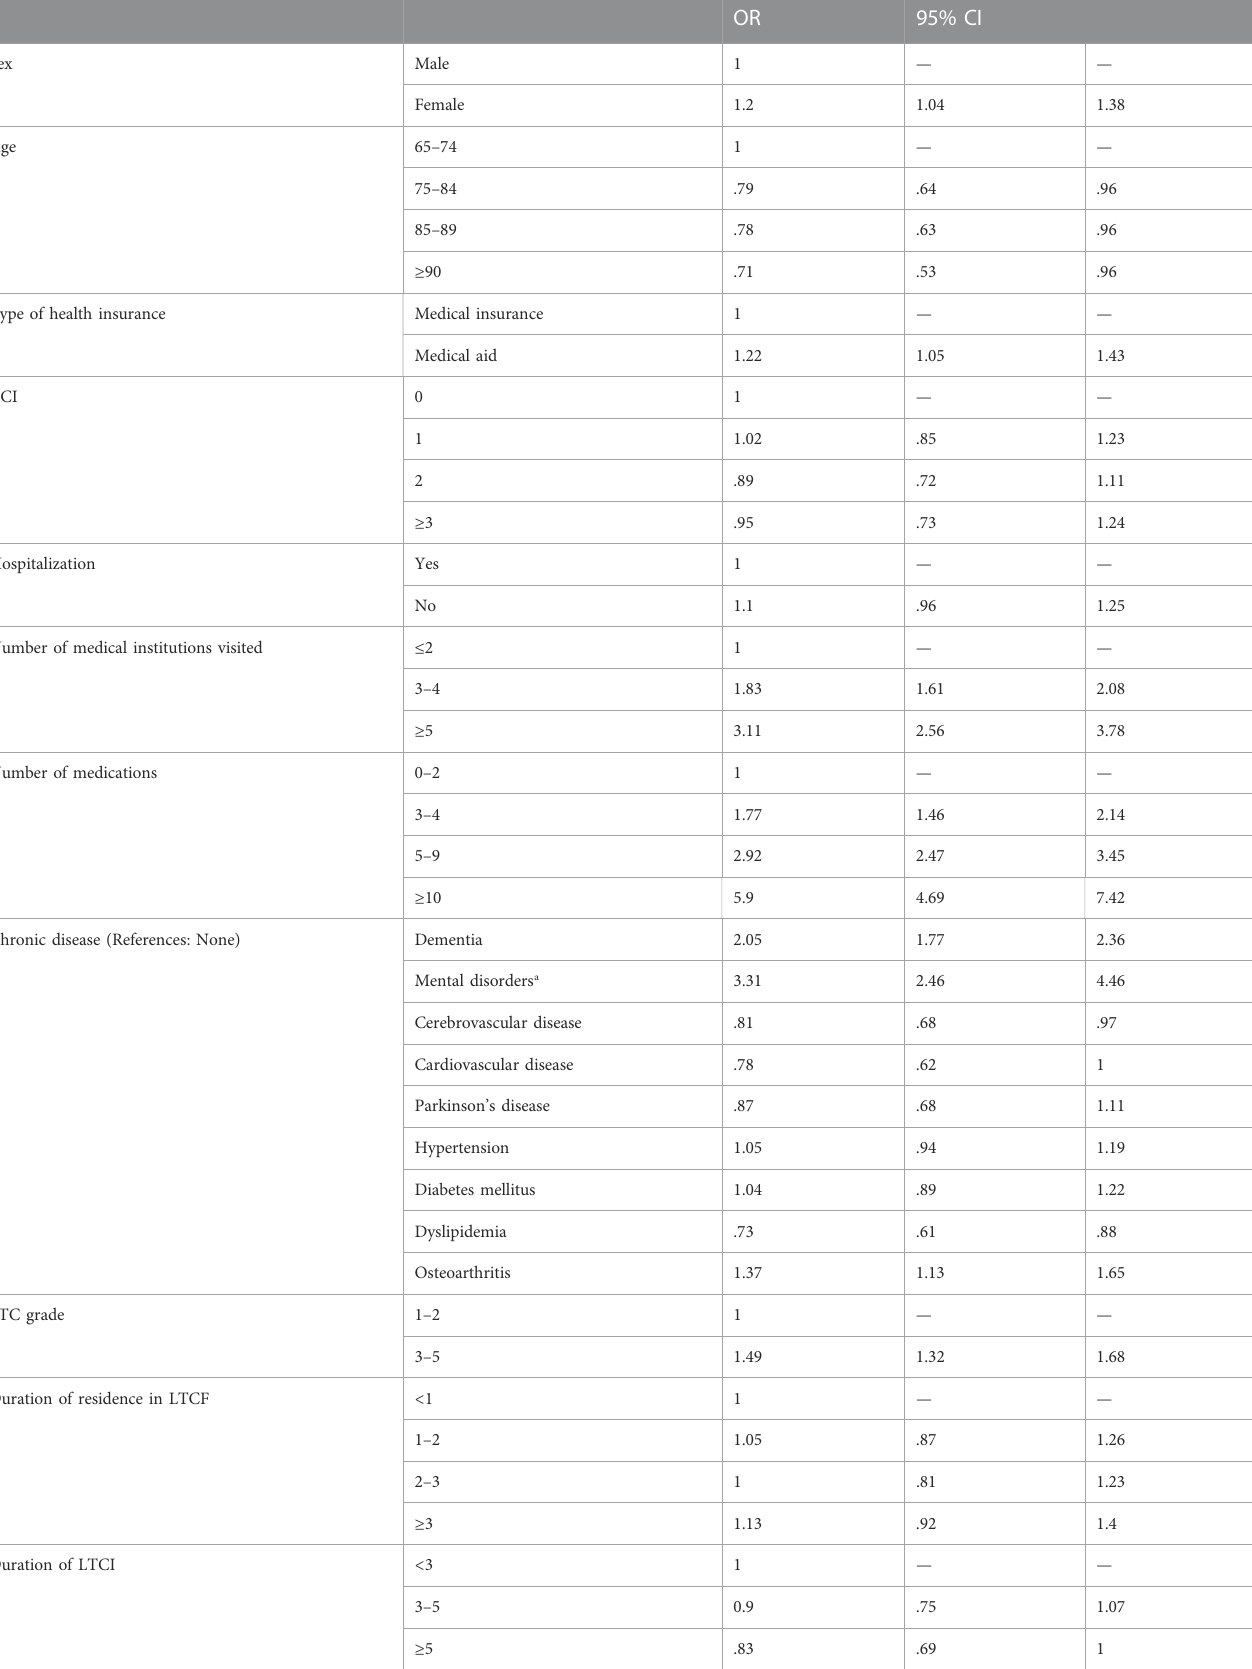
TABLE 4 Risk factors of potentially inappropriate medication use in long-term care facility